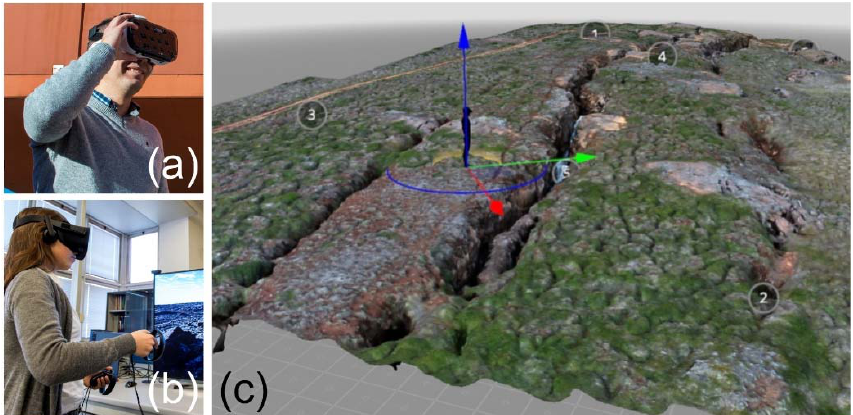
Figure 8. ( a ) The virtual geosite (VG) can be viewed through specially dedicated goggles and ( b ) navigated with the aid of joysticks. ( c ) Example of an annotated 3D model where the viewer’s starting point and the height have been set up, as well as the direction of observation.